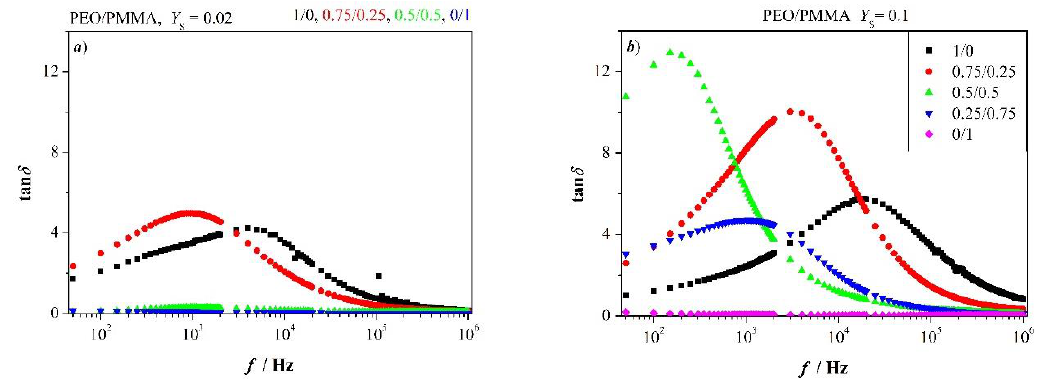
Figure 9. Tangent loss spectra for PEO / PMMA blends as indicated; ( a ) Y S = 0.02, ( b ) Y S = 0.1.